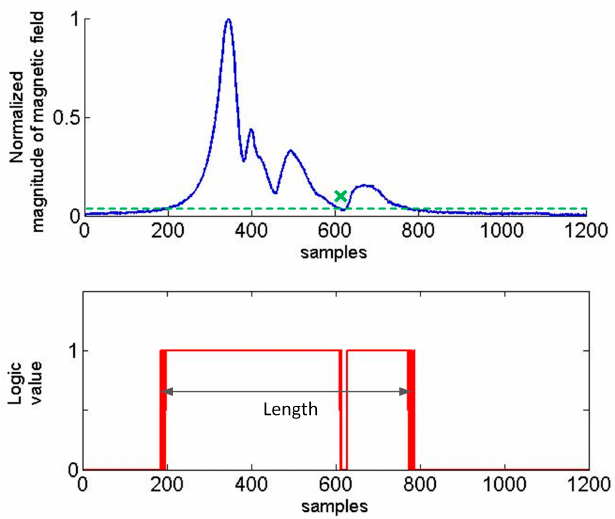
Figure 5. Toyota Auris—the magnitude signature length computation with a threshold level 0.035 G.